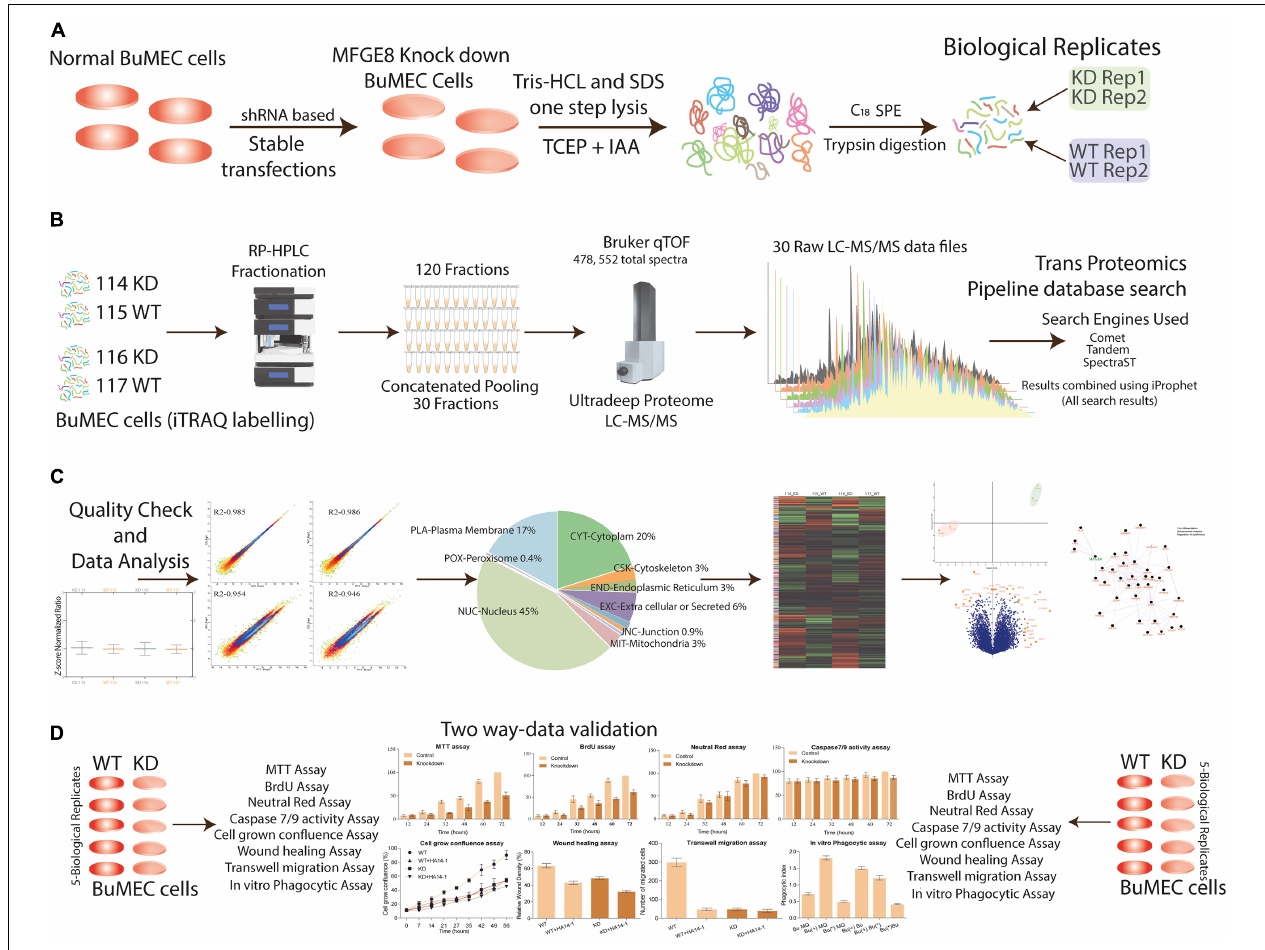
FIGURE 3 | Experimental design and quantitative proteomics workflow allow a comprehensive analysis of MFGE8 affected proteome. (A) BuMEC cells were transfected with shRNA for stable knockdown of MFGE8 protein expression, stably transfected cells grown for 120 h followed by quick lysis, protein extraction, quantification, and trypsin digestion for peptides generation in two biological duplicates (see the section “Materials and Methods”). (B) Peptides were labeled with iTRAQ labels, which are 114, 116 for KD (knockdown cells), and 115, 117 for WT (wild type cells treated with scrambled shRNA) followed by reversed-phase UHPLC based peptide fractionation. The fractions were concatenated pooled into 30 final fractions, and iTRAQ labeled peptides were analyzed by high-resolution qTOF-LC-MS/MS. The database search analysis was performed by using three search engines (Comet, Tandem, and SpectraST) in the environment of the transproteomics pipeline, further, the description of raw data processing as described in Section “Materials and Methods”. (C) Outline of mass spectrometer data processing and analysis is shown; necessary detailed methodologies are provided in the Section “Materials and Methods.” For relative quantification, data were filtered and normalized to make sure fair evaluation across all duplicate biological samples. The resulting identified proteins were used for their localization in the cell compartments. The heat map was generated for clustering the group of proteins. Principal component analysis was performed to verify the isolation of the components of different labels. Finally, the volcano plot was graphed to identify the significantly differentially express proteins. These DEPs were used for network analysis, and lastly, the biological MFGE8 based regulatory pathway was predicted. (D) The validation using the different biological